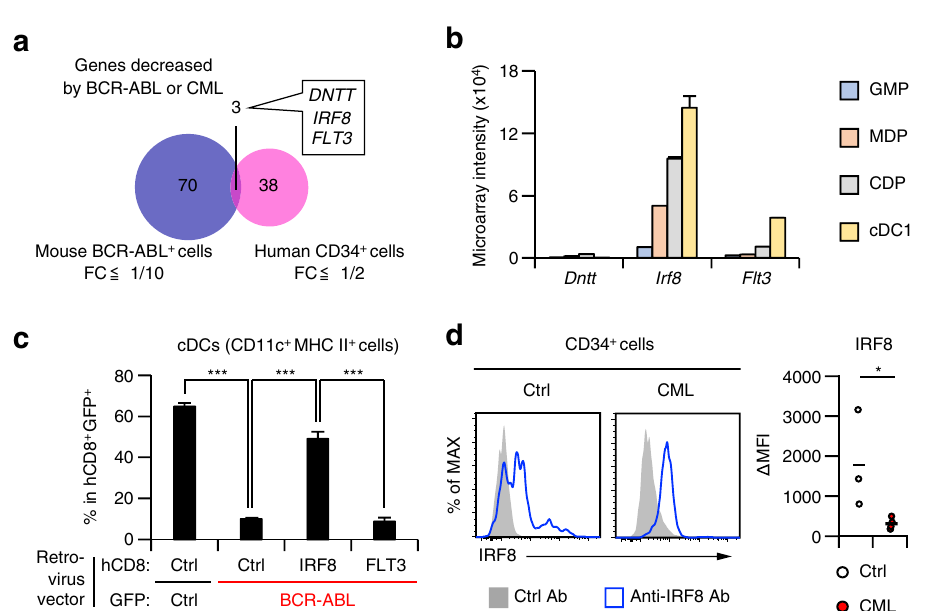
Figure 3. IRF8 expression in progenitors of CML patients. ( a ) A Venn diagram showing the overlap of genes downregulated in mouse bone marrow Lin − cells transduced with BCR-ABL in vitro for 3 days and in CD34 + cells of CML patients. FC, fold change. ( b ) Normalized microarray intensities of Dntt , Irf8 , and Flt3 in mouse DC lineage progenitors. ( c ) Proportion of cDCs in in vitro mouse DC culture co-transduced with BCR-ABL and IRF8 or FLT3 (n = 6). ( d ) IRF8 protein expression in human CD34 + cells (Normal controls [Ctrl], n = 3; CML patients [CML], n = 4). Data were retrieved from GSE5550 ( a ), GSE44920 ( a ), and GSE84509 ( b ) and analysed. Values in ( b ) and ( d ) are the mean ± SD. The horizontal lines in ( d ) indicate mean values. * P < 0.05, ** P < 0.01, *** P < 0.001 (Student’s t